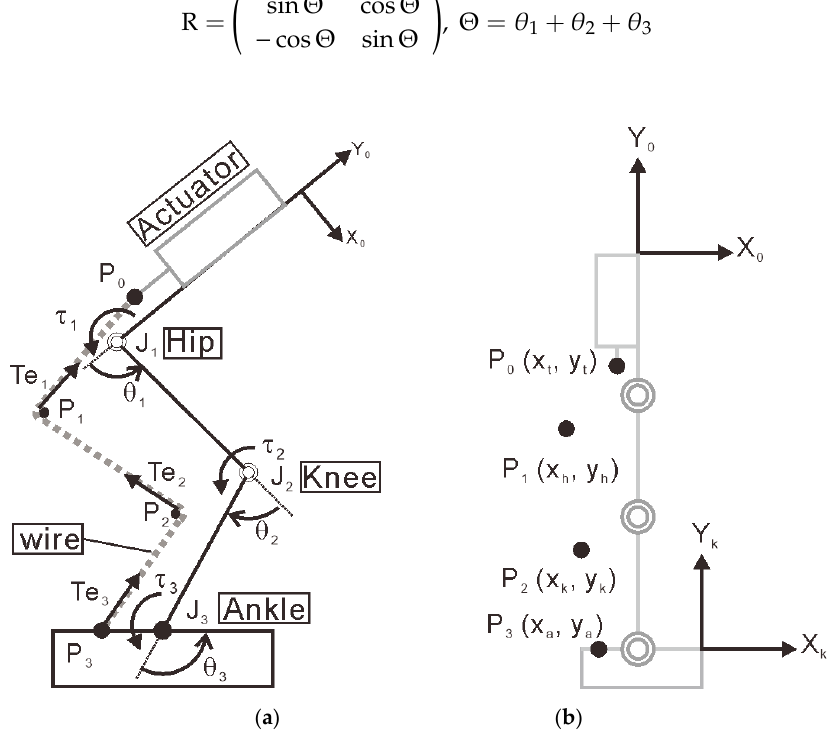
Figure 1. Joint configuration and position of pulley. ( a ) Wire, pulley, and joint configuration; ( b ) Pulley position with respect to the coordinate system ( Σ k ).